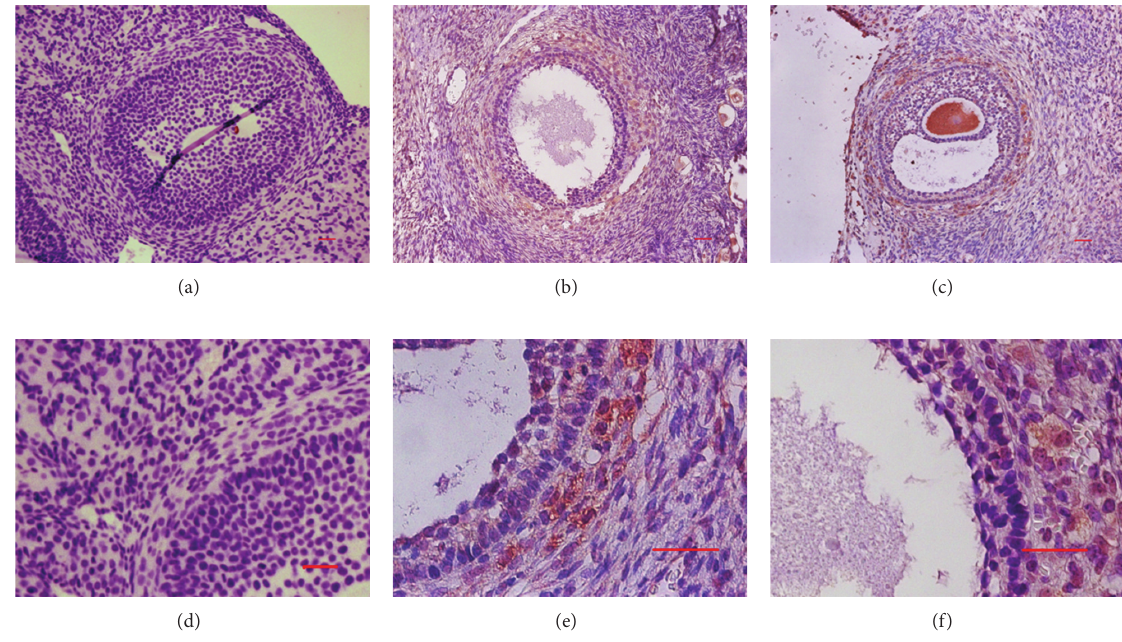
Figure 1: Cellular localization of SET protein in normal and polycystic ovaries. Immunohistochemical localization of SET protein was mainly in the theca cells and oocytes in both PCOS ovarian tissues (b, e) and normal ovarian tissues (c, f). The positive immunoreactive signals were visualized as brown stain ((b, c): original magnification of 20x; (e, f): original magnification of 40x; scale bar = 20 𝜇 m). Negative controls were executed simultaneously, of which the primary antibody was the IgG (a, d).